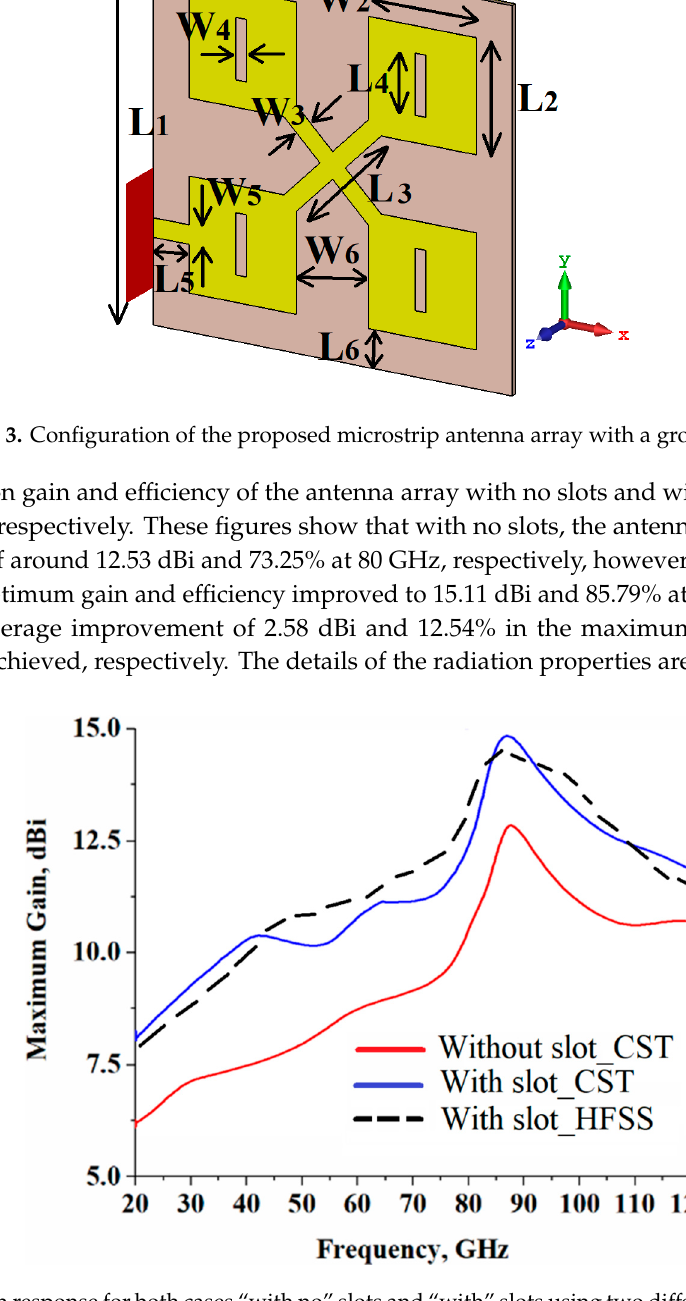
Figure 2. Reflection-coefficient (S 11 < − 10 dB) response of the microstrip antenna array “without” slots and “with” slots using two different commercially available 3D full wave electromagnetics simulation tools (CST Microwave Studio ® and HFSS™).